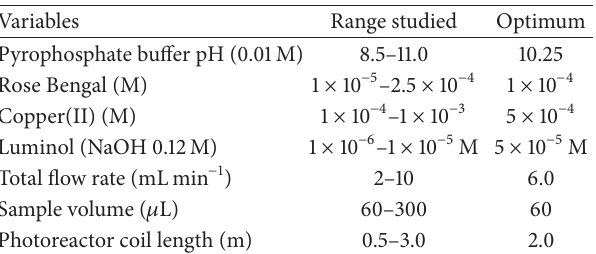
Table 1: Selection of